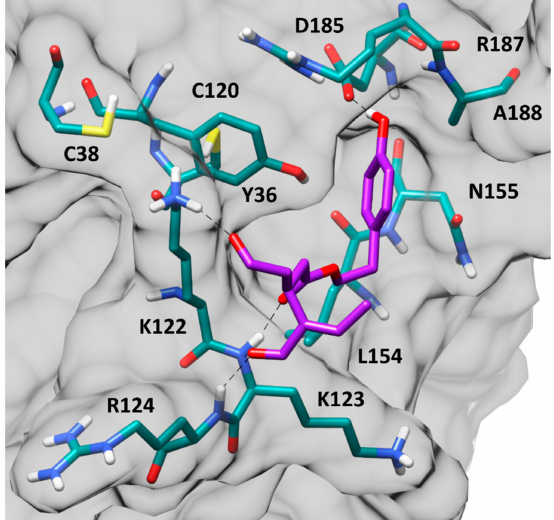
Figure10. MinimizedaveragestructureofOCboundtop65monomeroftheNF- κ Bp50 / p65heterodimer, derived from the last 20 ns of MD simulation. Hydrogen bonds are represented as black dashed lines, while the protein surface is shown in